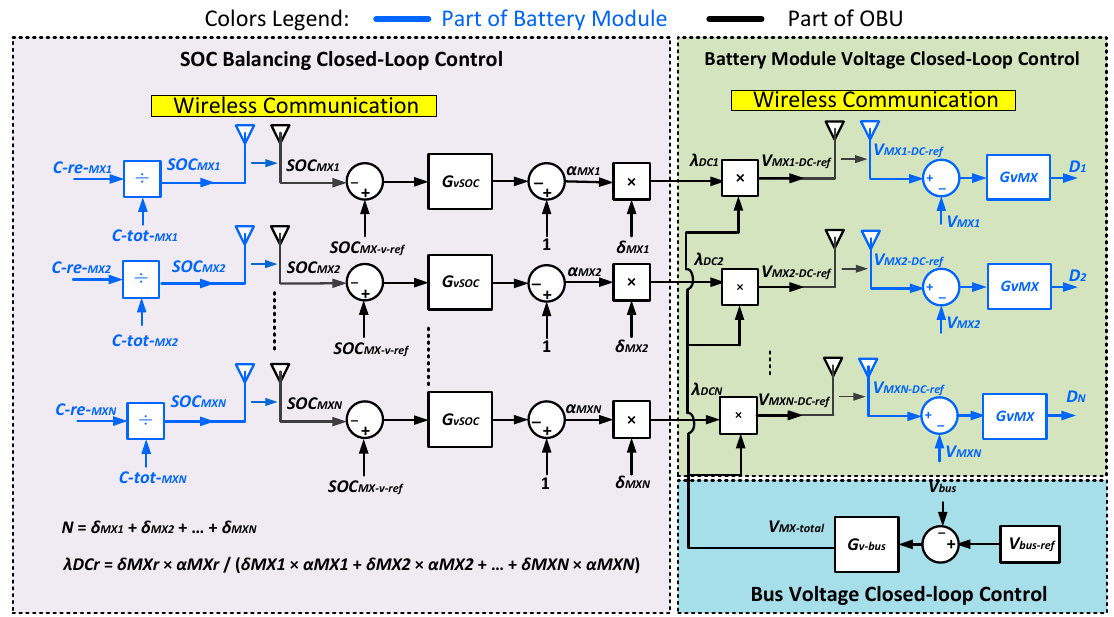
Figure 2. Illustration of the WEDES controller presented in [1].